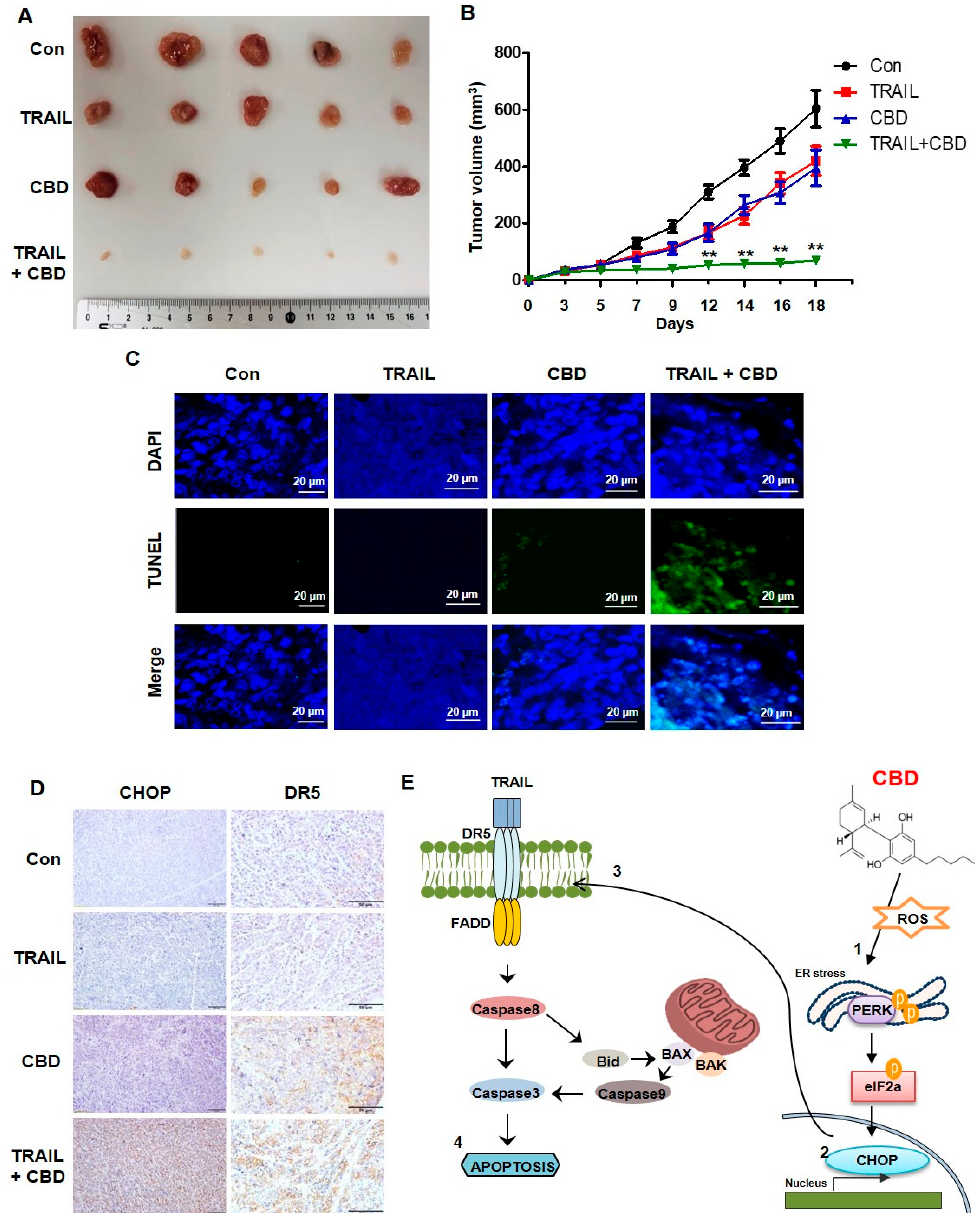
Figure 5. Combined antitumor effects of cannabidiol and TRAIL on colorectal cancer in vivo ( A , B ) DLD-1 cells were inoculated into nude mice ( n = 5 per group) at 3 × 10 6 per mouse subcutaneously. Mice ( n = 5) received 4 ng/kg TRAIL and 10 mg/kg cannabidiol either alone or in combination at day 30 after tumor implantation. Representative tumors of each group are shown. ( C ) TUNEL staining of paraffin-embedded tumors. ( D ) IHC staining for CHOP and DR5 in paraffin-embedded tumors. Scale bar 50 μ m. ( E ) Proposed mechanism of cannabidiol activity. CBD, cannabidiol. ** p < 0.01.